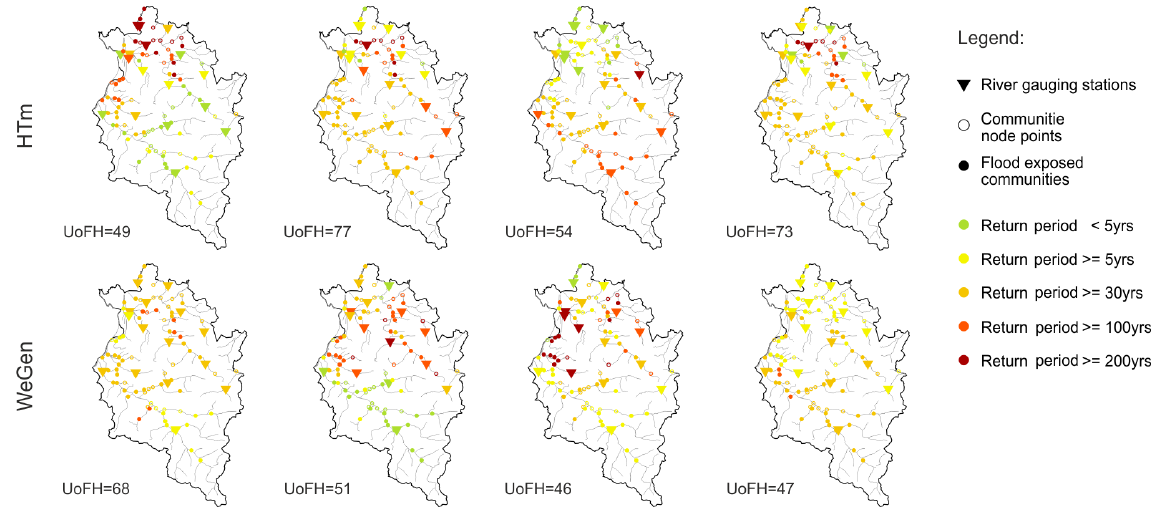
Figure 7. Examples of flood events with an estimated flood damage of EUR100 ± 1 million flood damage for the HT-model and WeGen approach. The general severity of flood events is characterised by the unit of flood hazard (UoFH).